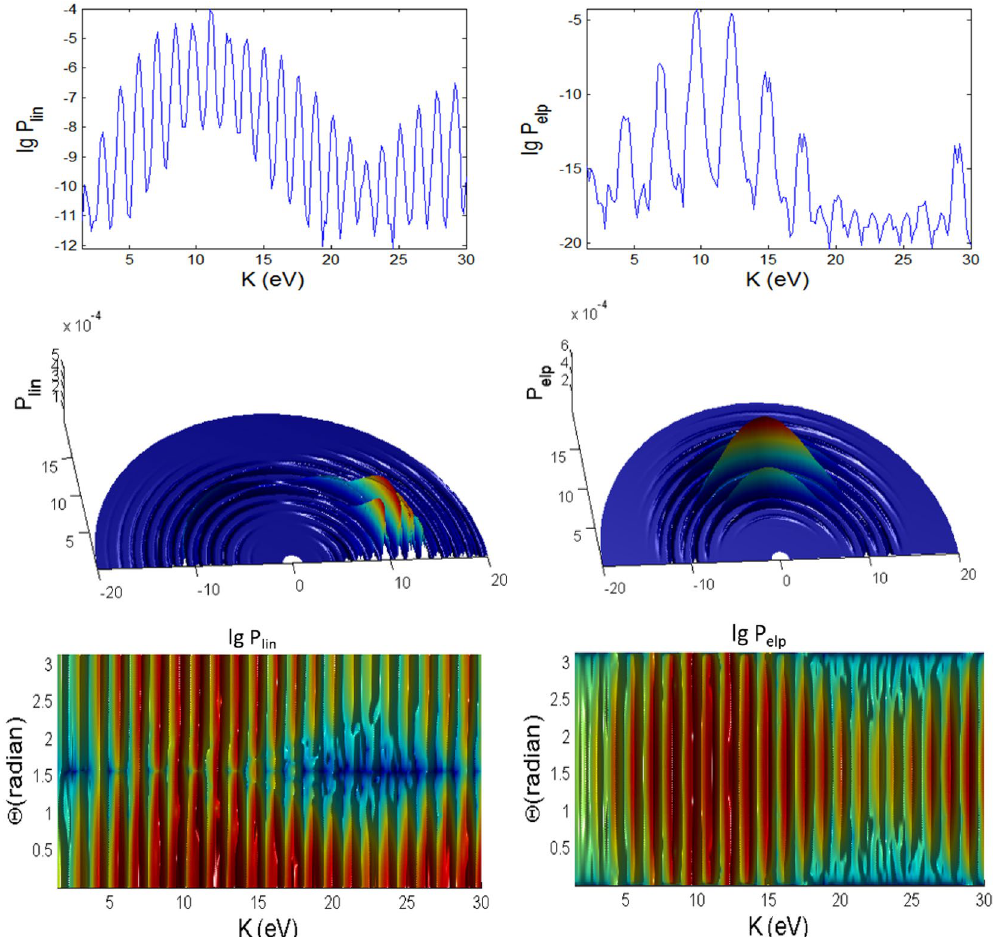
Figure 6. Photoionization probability with t p = 100 fs , versus angle Θ at Φ = 0 and kinetic energy ( K ) for case A characterizing the intermediate regime. The bottom panels are K - Φ map with probability in log scale. The is no Stark effect and no CEP